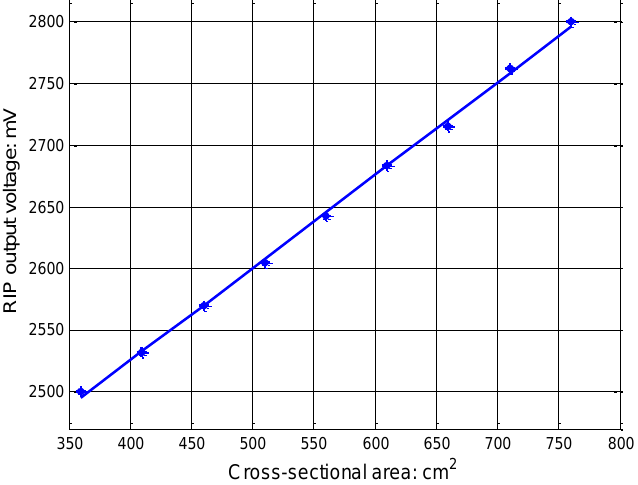
Figure 6. Relationship between RIP output voltage and coil cross-sectional area. Regression line is based on linear polynomial least-square